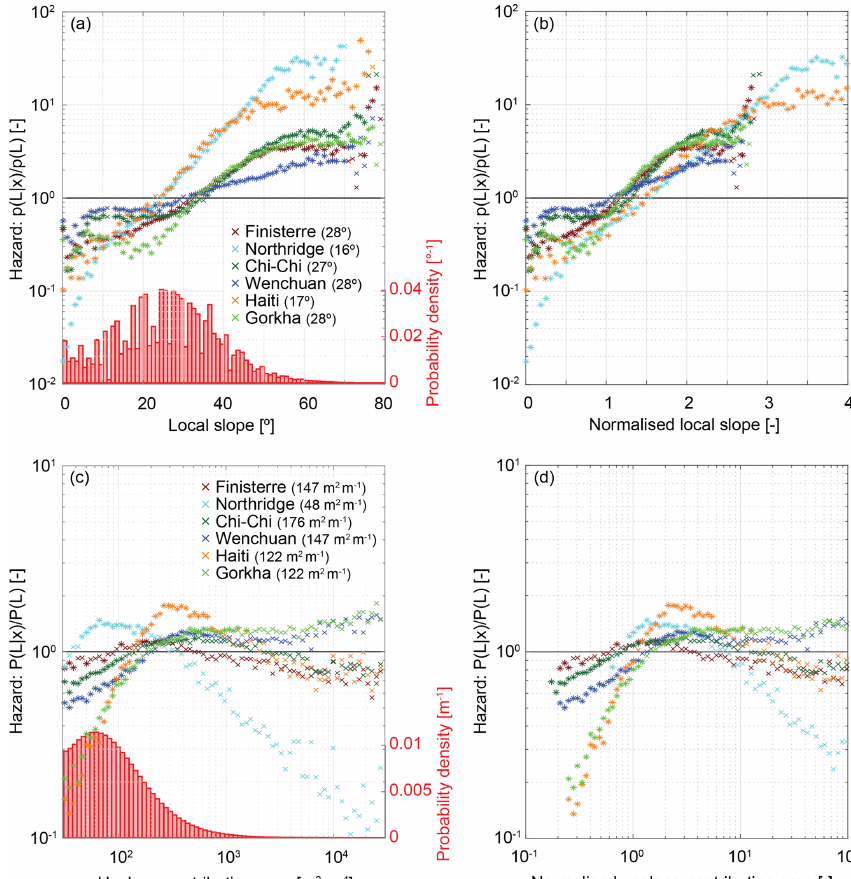
Figure 3. Landslide hazard defined as conditional probability P(L | x) normalised by study area average landslide probability P(L) , where x is (a) local slope; (b) local slope normalised by the study area average slope; (c) upslope contributing area per unit cell width; and (d) upslope contributing area normalised by the upslope contributing area of the inflection in average slope. Solid black lines show normalised probability of 1, the study area average; thus, points above this line have above-average landslide hazard compared to the study area as a whole. Asterisks indicate values for which conditional probability differs from the study area average probability at 90% confidence. Red bars in (a) and (c) show histograms of local slope and upslope contributing area over the six inventories. Numbers in brackets show study area average slopes in (a) and upslope contributing area at the hillslope–channel transition in (c)